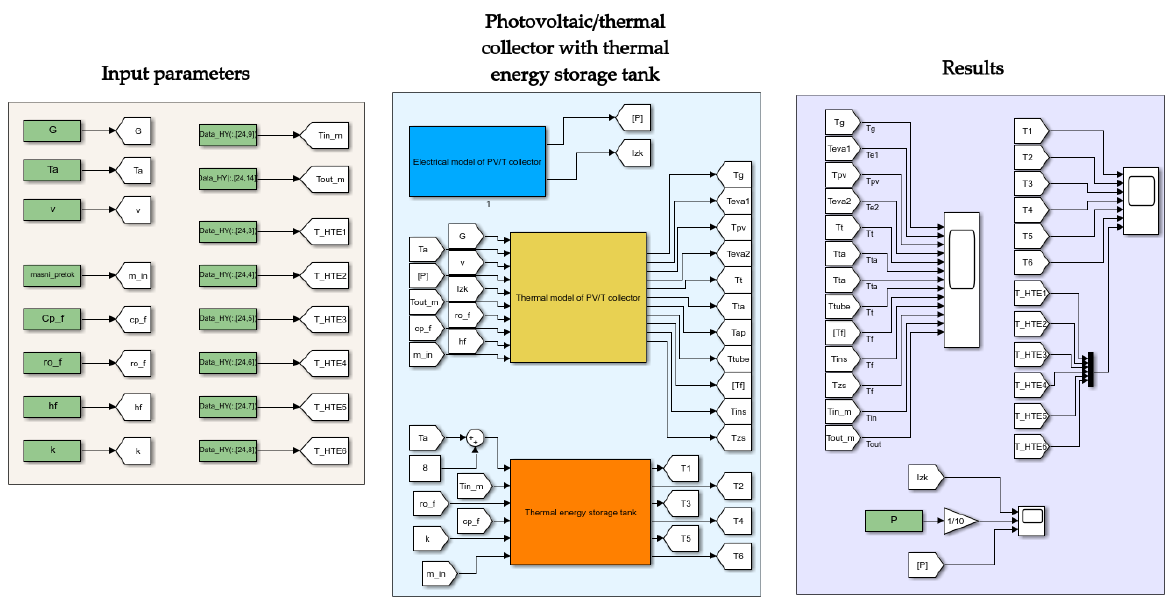
Figure 2. PV/T system: ( 1 ) PV/T modules, ( 2 ) heat exchangers, ( 3 ) refrigeration unit, ( 4 ) TEST, ( 5 ) pyranometer, and ( 6 ) anemometer and ambient temperature sensor.